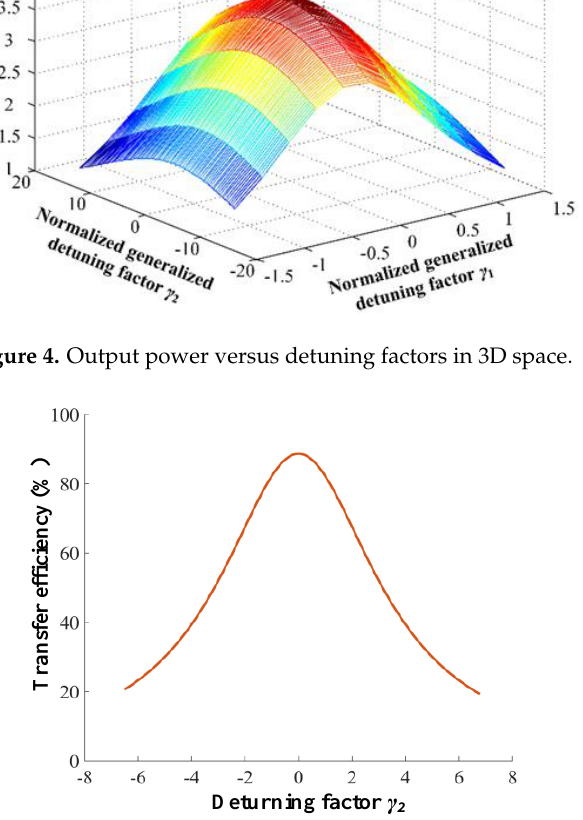
Figure 5. Transfer efficiency versus detuning factor of secondary side.